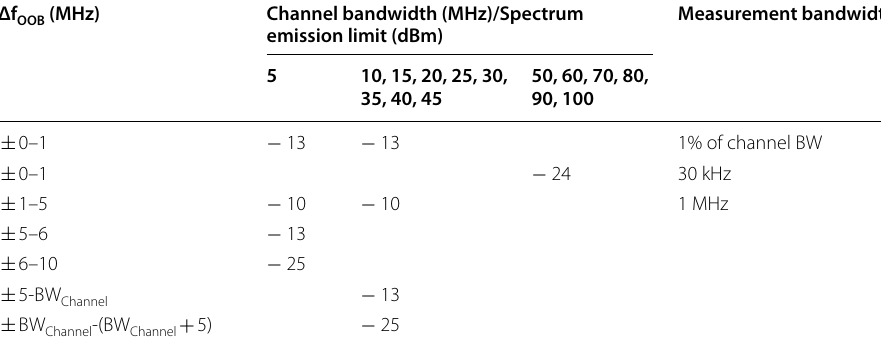
Table 2 General NR spectrum emission